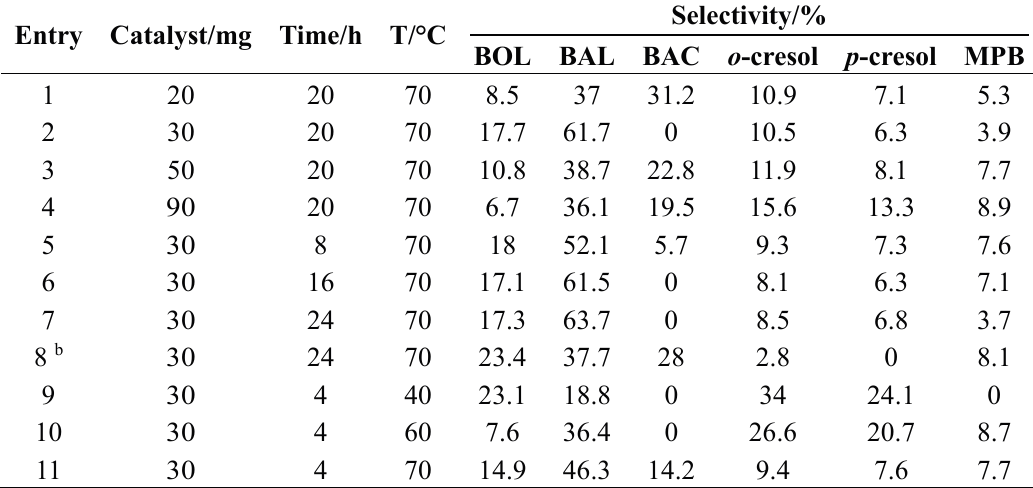
Table 2. Selective oxidation of toluene on Cu-CNB with H 2 O 2 as oxidant a